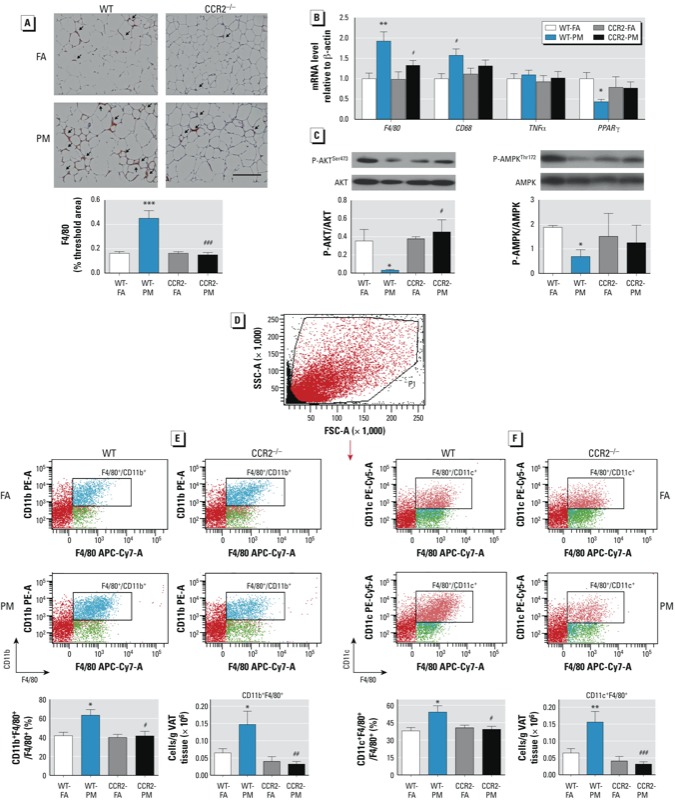
Effect of PM2.5 exposure and HFD on inflammation and insulin signaling in VAT from WT and CCR2–/– mice; animals were exposed to PM2.5 or FA for 17 weeks. (A) Representative image (top; bar = 100 μm) and analysis of F4/80+ staining. (B) mRNA levels of genes involved in inflammation (F4/80, CD68, TNFα, and PPARγ). (C) Western blots and analysis of phosphorylated AKT (P-AKT)/total AKT (left) and phosphorylated AMPK (P-AMPK)/total AMPK (right). (D) Representative flow cytometric dot plot of living cells. (E–F) Representative flow cytometric dot plots showing F4/80+/CD11b+ (E) and F4/80+/CD11c+ (F) with respective analysis by relative percentage or absolute cell count/g VAT. Data are presented as mean ± SE of 7–9 mice/group)
*p < 0.05, **p < 0.01, and ***p < 0.001, compared with the WT‑FA group. #p < 0.05, ##p < 0.01, and ###p < 0.001 compared with the WT‑PM group.